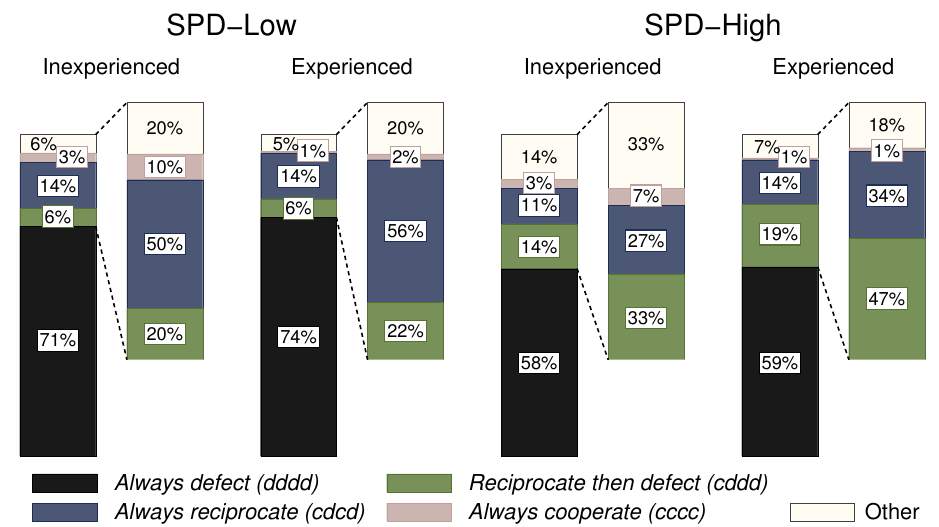
Figure 1. Distribution of observed strategies of second movers. Note: The figure shows distributions of all observed strategies (the bar on the left) and also zooms in on the distributions of observed strategies that involve some cooperation by second movers (the bar on the right). The label “inexperienced” refers to behavior when players play the experimental game for the first time. The label “experienced” refers to behavior in the last five repetitions of the